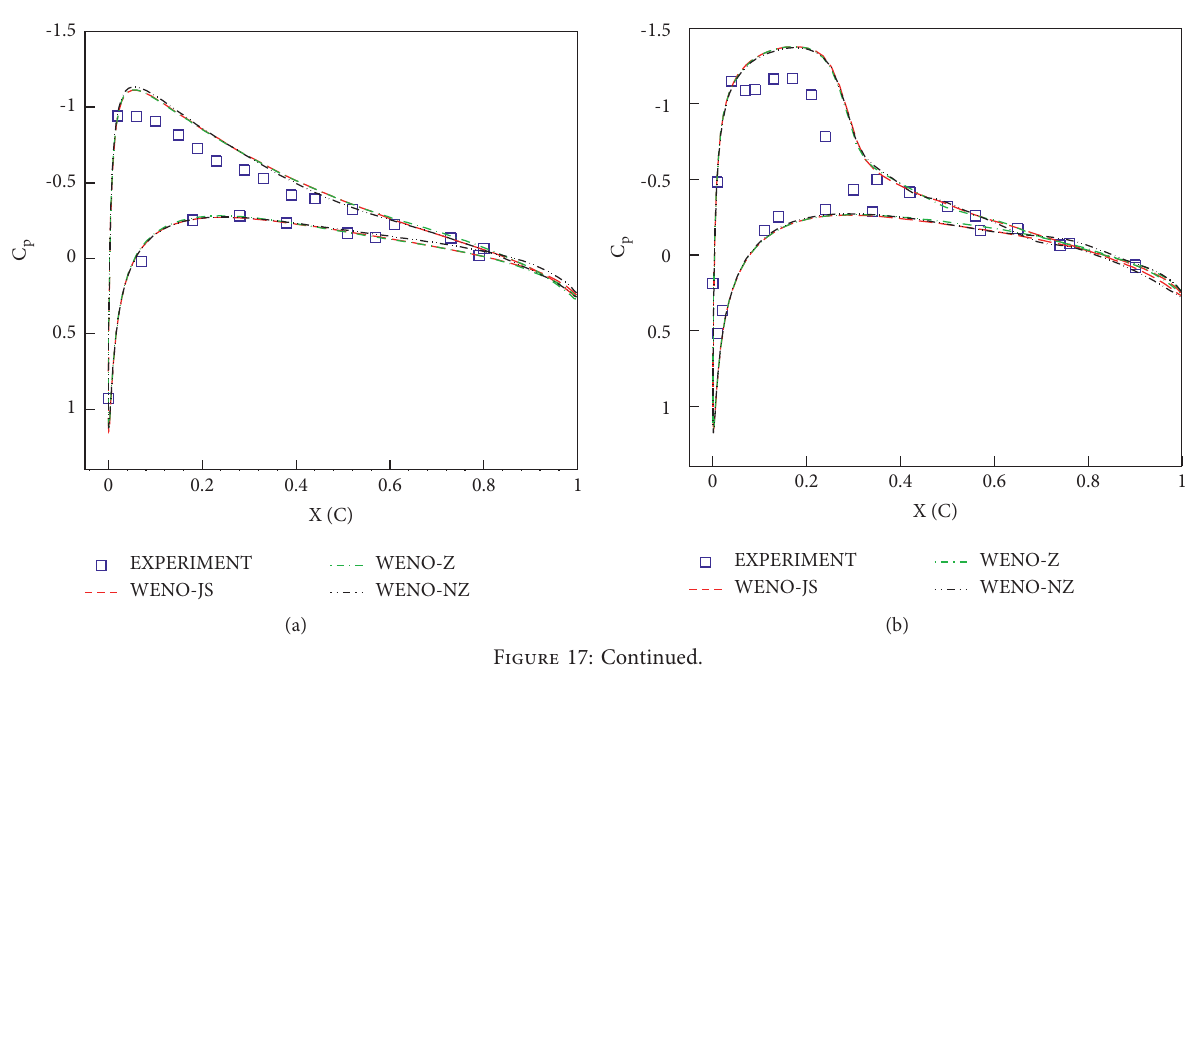
Figure 16: Schematic diagram of periodic boundaries. (a) Schematic diagram of aerial view for two blades. (b) Periodic boundary.